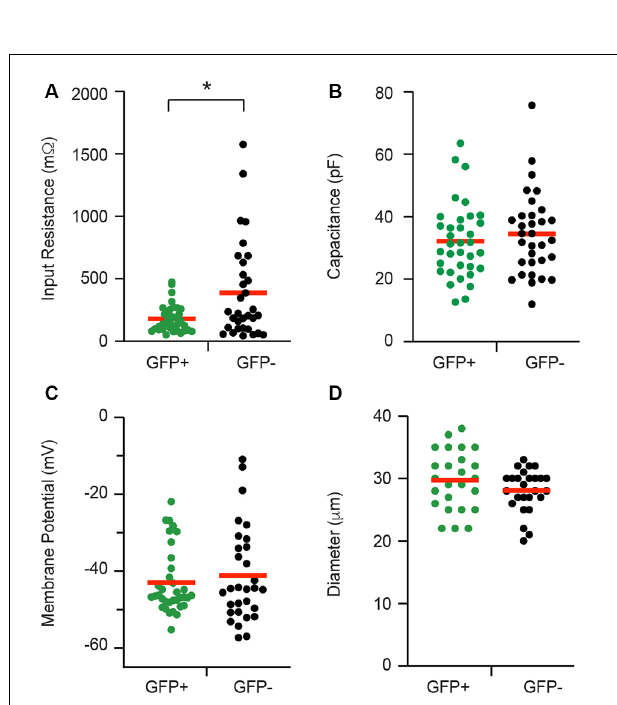
FIGURE 2 | Passive electrical properties of proprioceptive DRG cells. Baseline properties of green fluorescent protein positive (GFP+) proprioceptive neurons and unidentified green fluorescent protein negative (GFP − ) neurons were assessed during patch-clamp recordings. Scatter plots compare passive properties, including input resistance (A) , membrane capacitance (B) , resting membrane potential (C) , and cell diameter (D) . Values for GFP+ cells are shown in green while GFP − data appear black. Red horizontal bars indicate the mean for each group. Input resistance was the only property that differed between the two groups and was significantly lower in GFP+ recordings ( p = 0.008). * p ≤ 0.05.